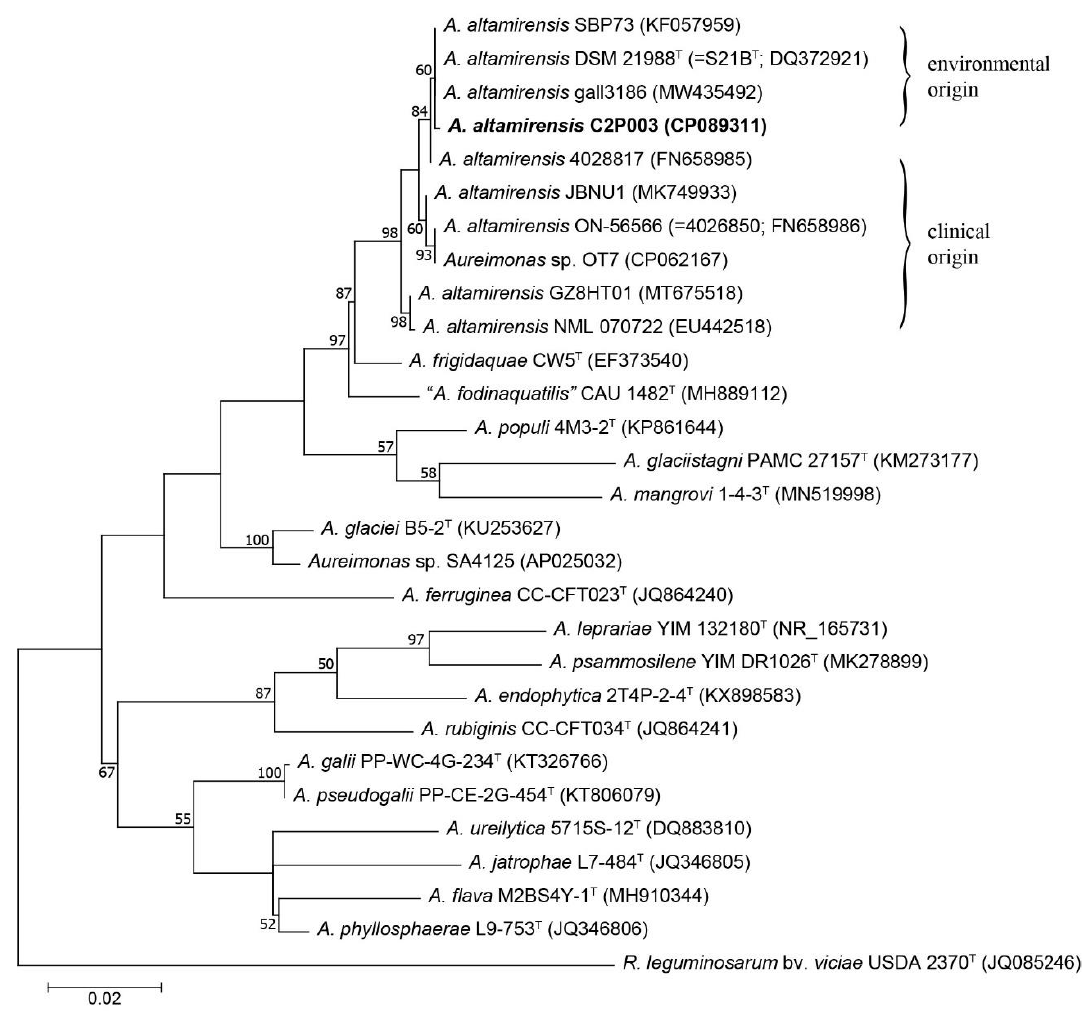
Figure 2. Maximum-likelihood tree of the 16S rRNA gene sequences showing the position of A. altamirensis C2P003 among other A. altamirensis strains and reference strains of related Aureimonas species. Phylogenetic analysis was performed using the HKY+G+I model. Rhizobium leguminosarum was used as the outgroup. Numbers at branch nodes refer to bootstrap values >50%. Bar: substitu- tions per nucleotide site. Accession numbers or locus tags (NCBI or IMG database) are indicated in